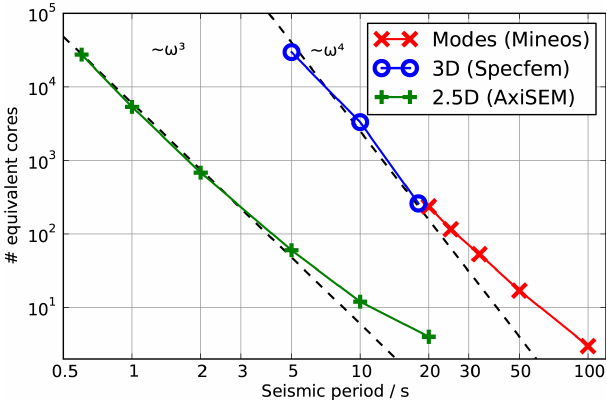
Figure 1. The cost of global wavefield simulations in “real time” (i.e., seismogram length equals wallclock simulation time) for dif- ferent methods. Each data point is based on actual simulation times, and gives as a result the number of processors needed to achieve this, assuming perfect scalability. The cost of normal-mode solu- tions (Mineos, available from geodynamics.org) and wave propa- gation in 3-D domains (SPECFEM, geodynamics.org) scales with the seismic period to the fourth power, whereas the axisymmetric method (AxiSEM) scales to the third power. We calculate the cost estimation upon saving 10 6 spatial points, a moderate task to com- pute wavefields. This is especially noteworthy for the mode solu- tion, whose cost scales directly with the number of saved spatial